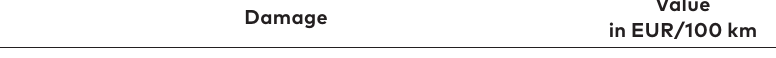
Table 3. Monetary evaluation of damage caused by light vehicles